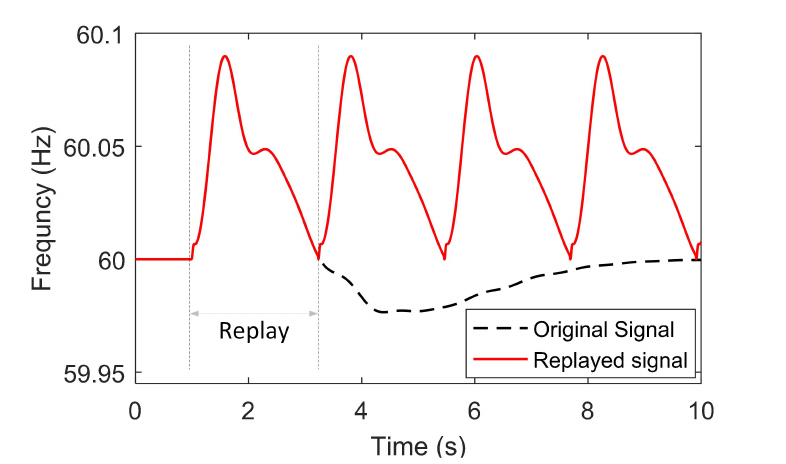
Figure 9. Original recorded data and replayed signals.